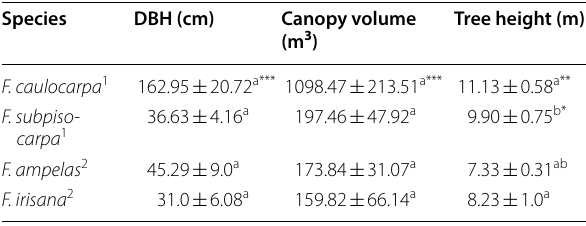
Table 1 Mean ( SE) DBH, canopy volume, and tree height ± of four species of figs assessed in the Hengchun Tropical Botanical Garden (HTBG), Kenting, and the comparison examined by